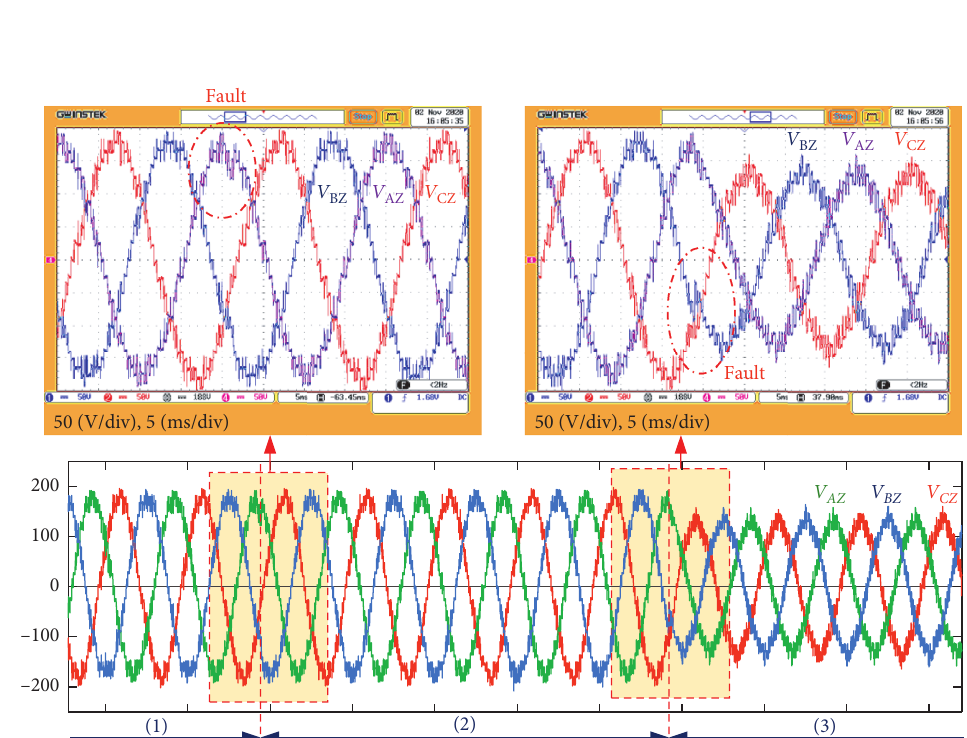
Figure 18: Inverter phase’s